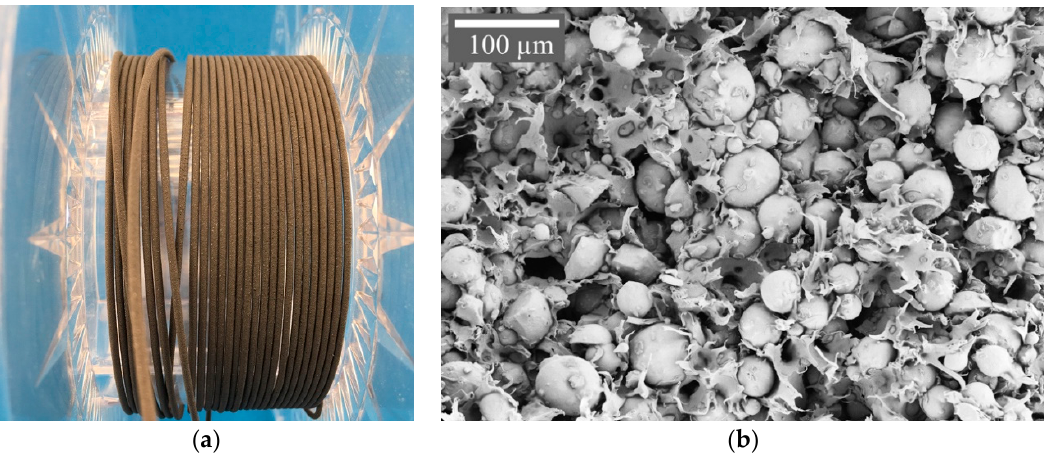
Figure 2. ( a ) Polymer-bonded magnetic filament flexible enough to be spooled on a standard filament spool with a diameter of 10 cm; ( b ) SEM micrograph of the extruded polymer-bonded magnetic compound, NdFeB particles inside the POM/PA12 matrix.